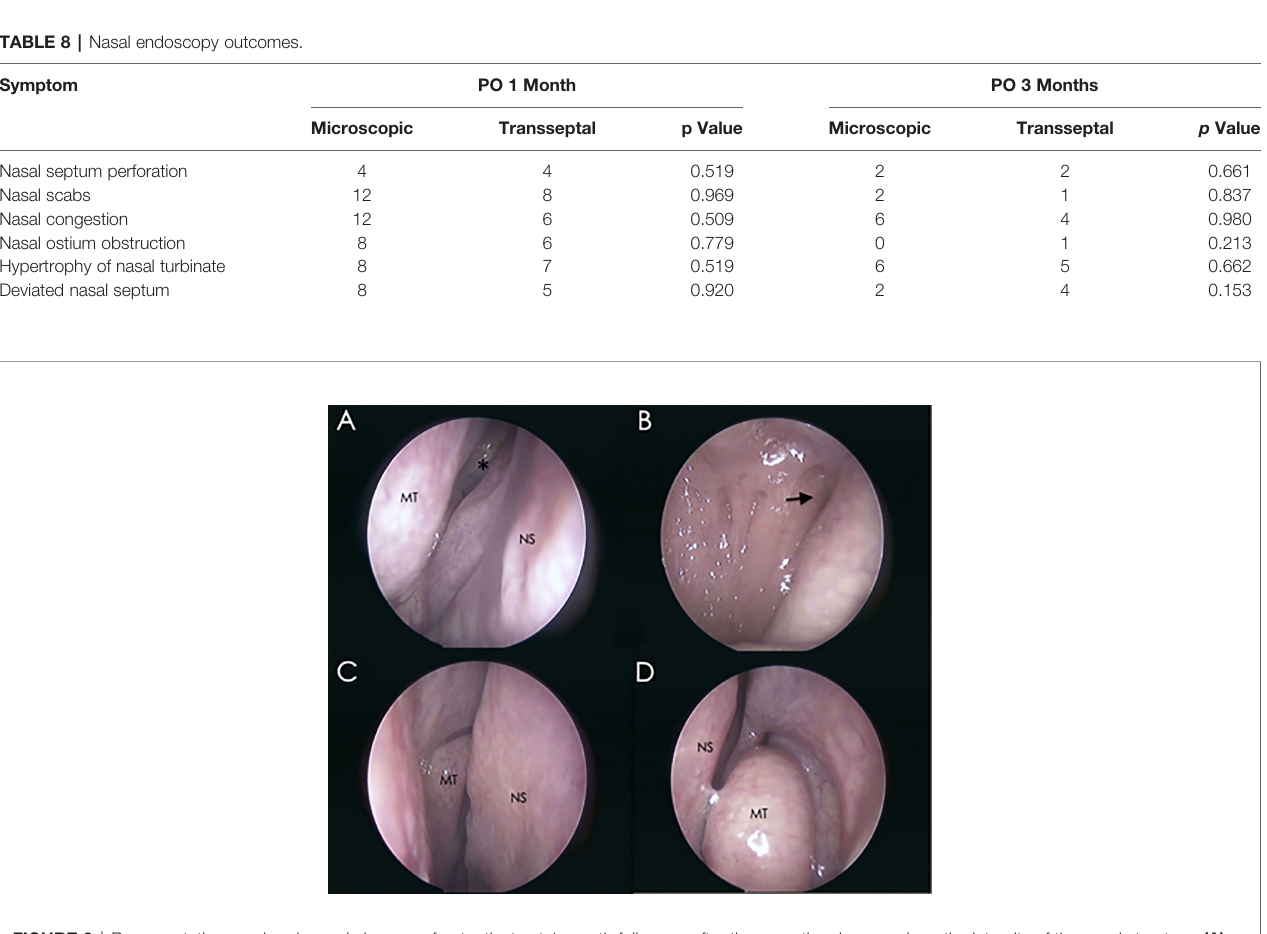
TABLE 9 | Complications.